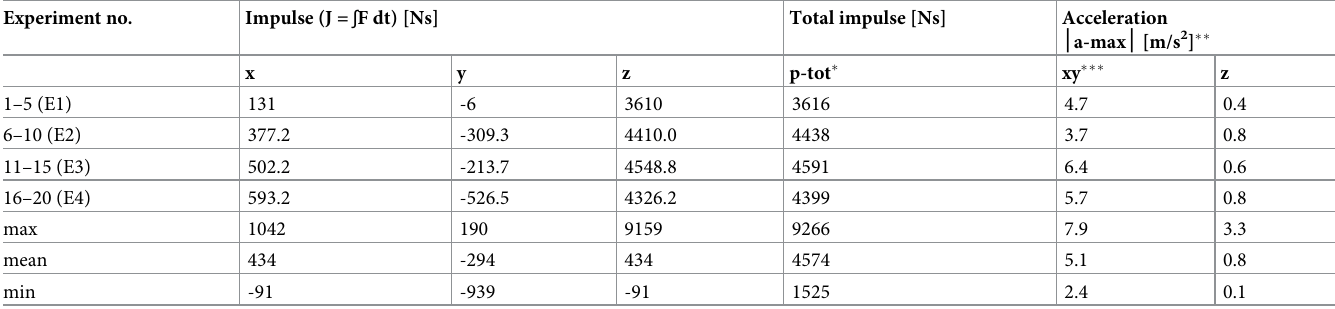
Table 3. Parameters of electrical drilling, Part 2 (E+no = mean of 5 drilling procedures). Experiment no.